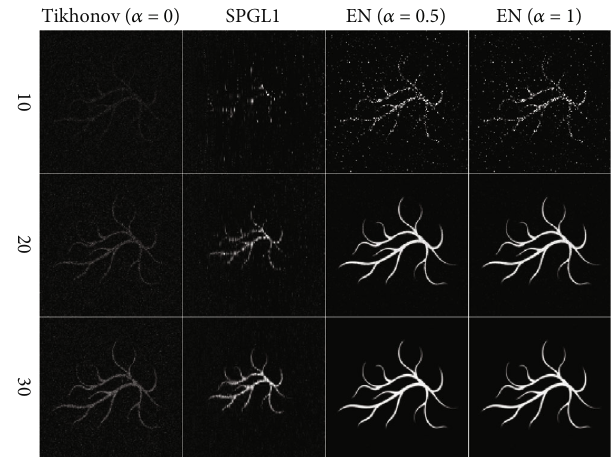
Figure 3: The blood vessel phantom results reconstruct by di ff erent methods. The fi rst to the third rows are the reconstruction results of 10, 20, and 30 views that are evenly distributed on the circumference individually. The fi rst to the fourth columns display results of the Tikhonov ð α = 0 Þ , SPGL1, EN ð α = 0 : 5 Þ , and EN ð α = 1 Þ ,